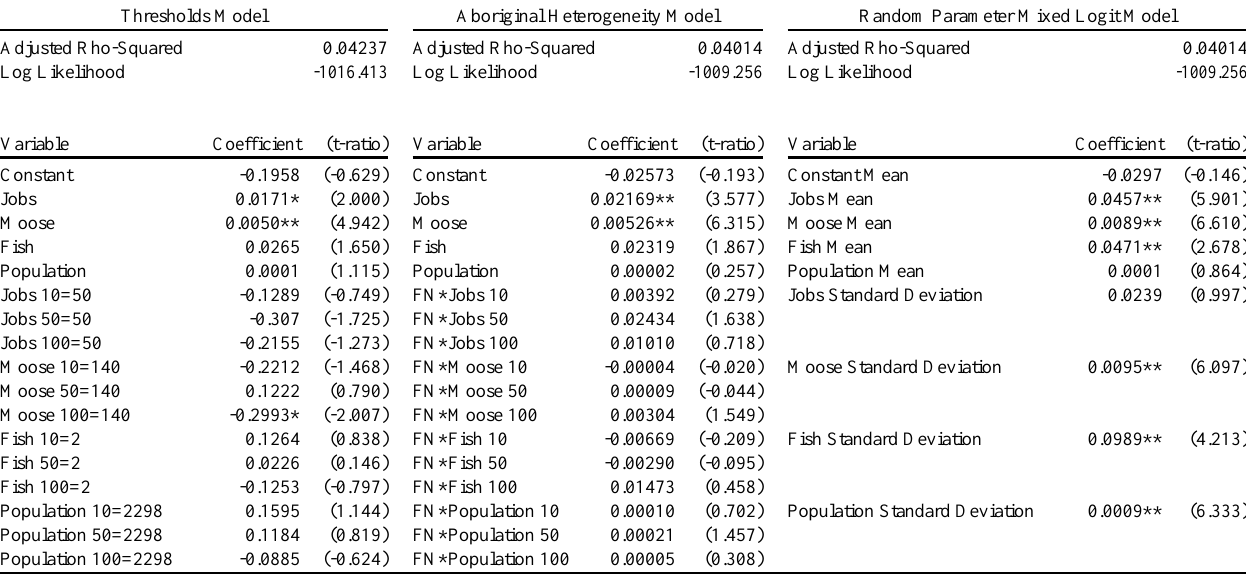
Table 4 . Thresholds and heterogeneity